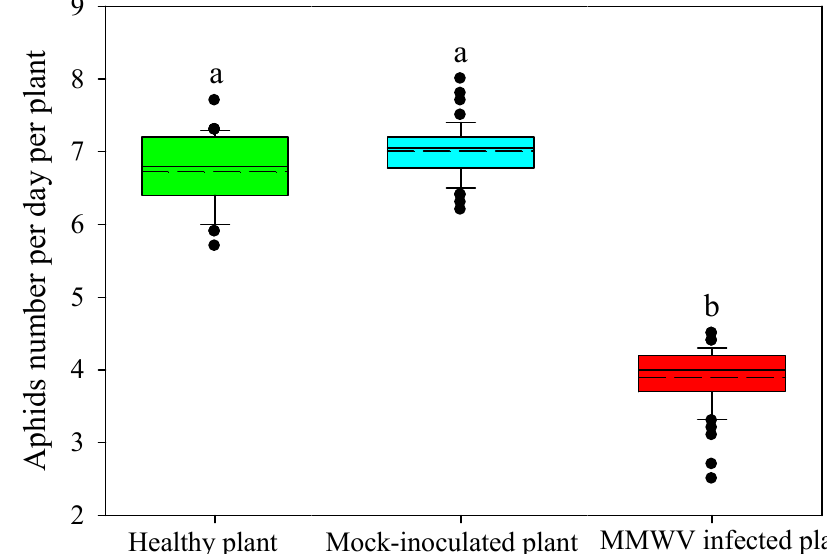
Figure 6. Effect of healthy plants (n = 50), mock-inoculated plants (n = 50), and MMWV-infected plants (n = 50) on the population growth rate of Myzus persicae . Box plot description: The long dashed line is the mean, the solid line is the median, the borders of the box are the first and third quartiles, the whiskers (error bars) represent 1.5 times the interquartile range, and points beyond the end of the whiskers are outliers. Different letters above bars indicate significant differences ( p < 0.05) according to Duncan’s multiple range test.